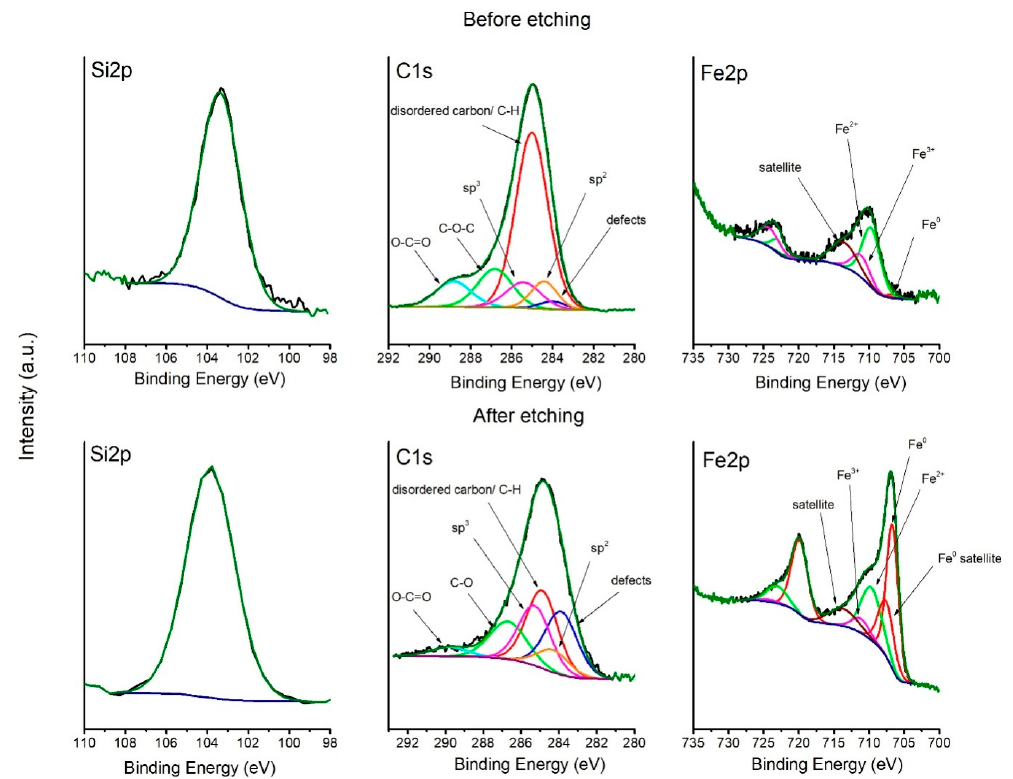
Figure 6. Deconvolution of Si2p, C1s, and Fe2p spectra before and after etching.